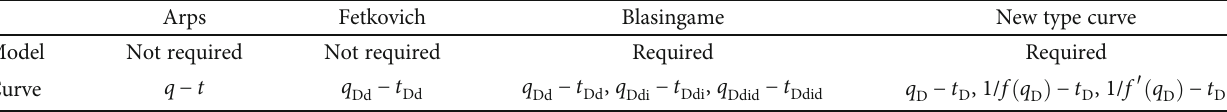
Table 1: Comparison among di ff erent methods of decline curve